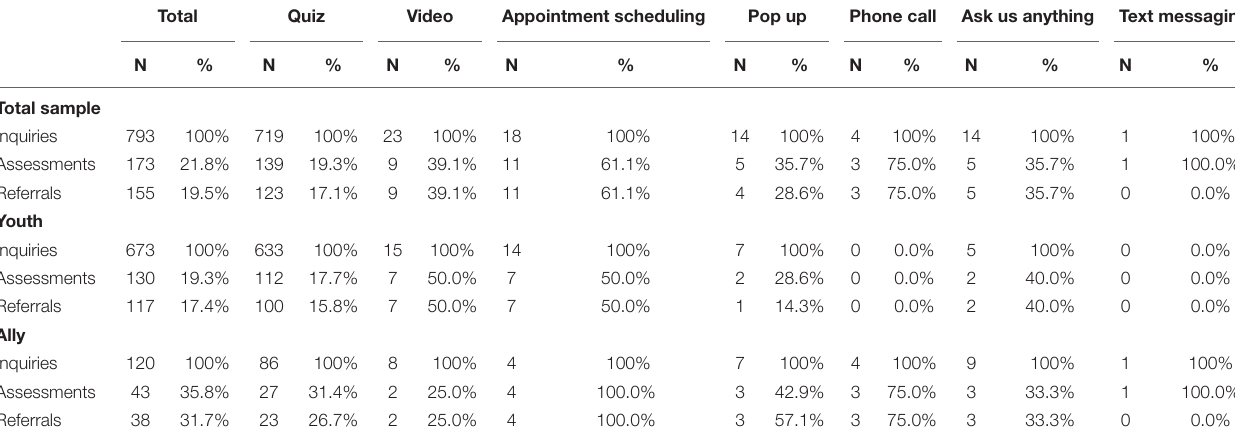
TABLE 4 | Trajectory from inquiry to assessment and referral, grouped by channel and